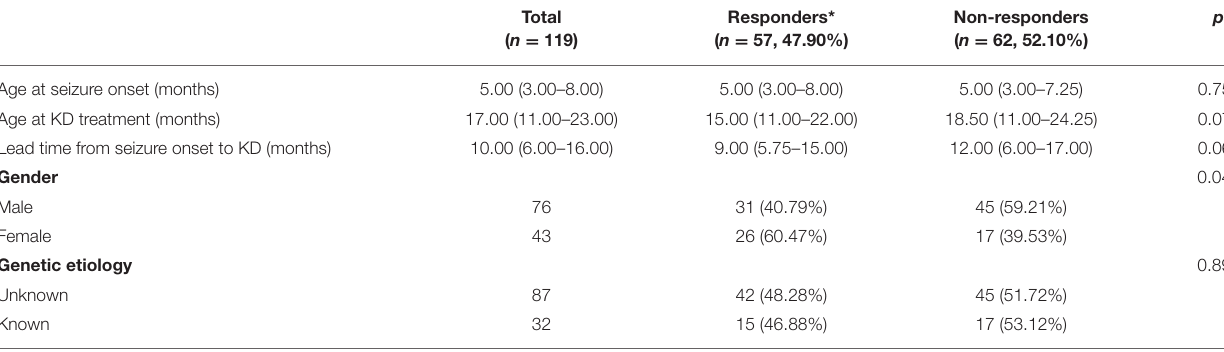
TABLE 1 | Demographics of patients and comparison between responders and non-responders after 16-week KD treatment (3:1).